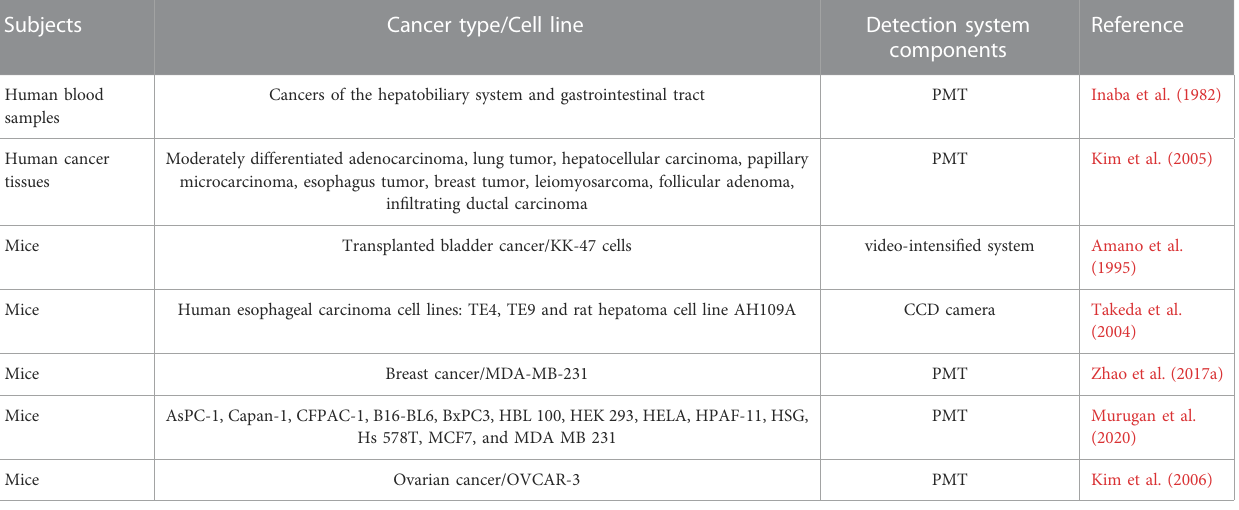
TABLE 3 Studies on the association between UPE and